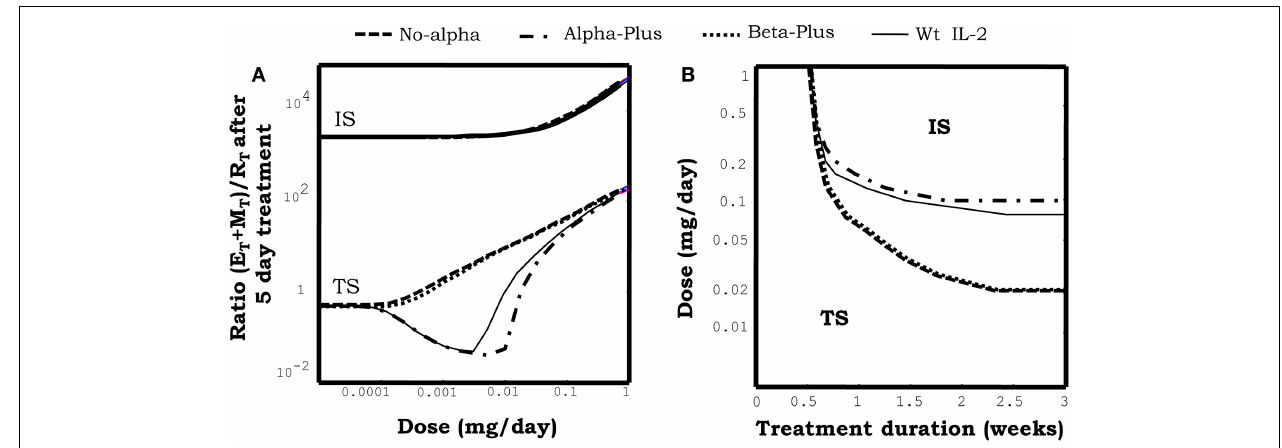
of treatment dose with ratio (E + M)/R reduced from its starting value. If No-alpha or Beta-plus mutants are used the pattern of response obtained is qualitatively different.The ratio (E + M)/R always increase (favoring the expansion of E and M cells) and the larger the dose applied the larger the increment. If the simulations start with a system at the IS, all the mutants variants behave like the wild-type IL2, they promote in dose-dependent way a further expansion of E and R cells, increasing the ratio (E + M)/R.The graph in (B) shows the minimal effective dose versus the treatment duration, required to induce the transition to the IS in a system initialized in theTS, for the treatment with different variants of IL2 mutants. It can be seen that the injection of No-alpha and Beta-Plus IL2 mutants is more efficient than the injection of wild-type IL2 alone to breakdown tolerance in an initial tolerant system, i.e., it requires less dose to achieve a similar